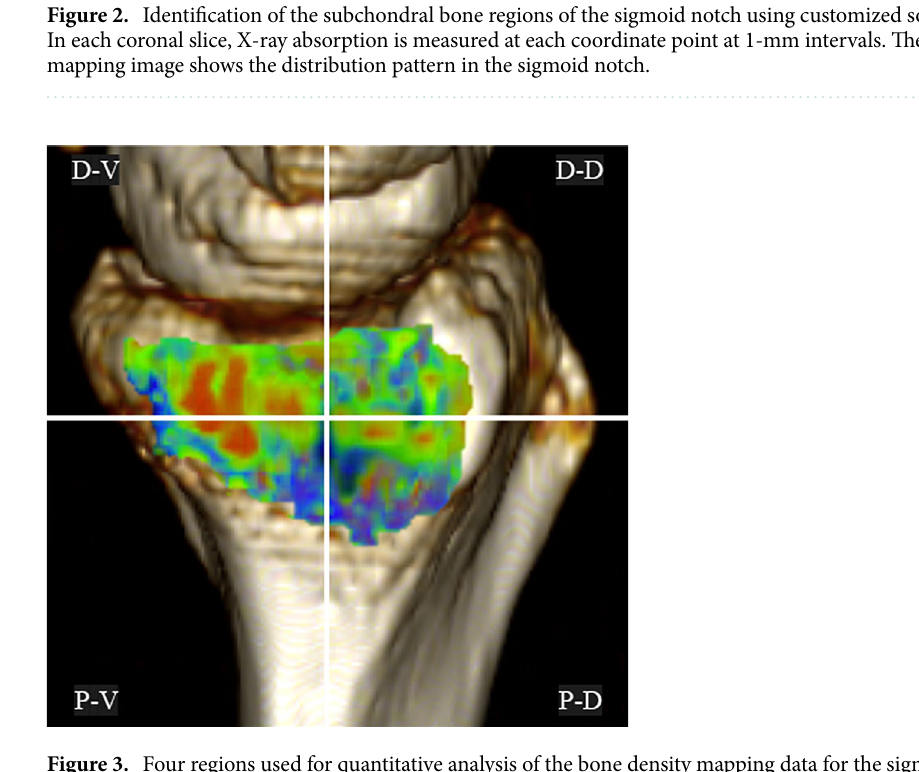
Figure 3. Four regions used for quantitative analysis of the bone density mapping data for the sigmoid notch. D-V Distal-volar, D-D Distal-dorsal, P-V Proximal-volar, P-D